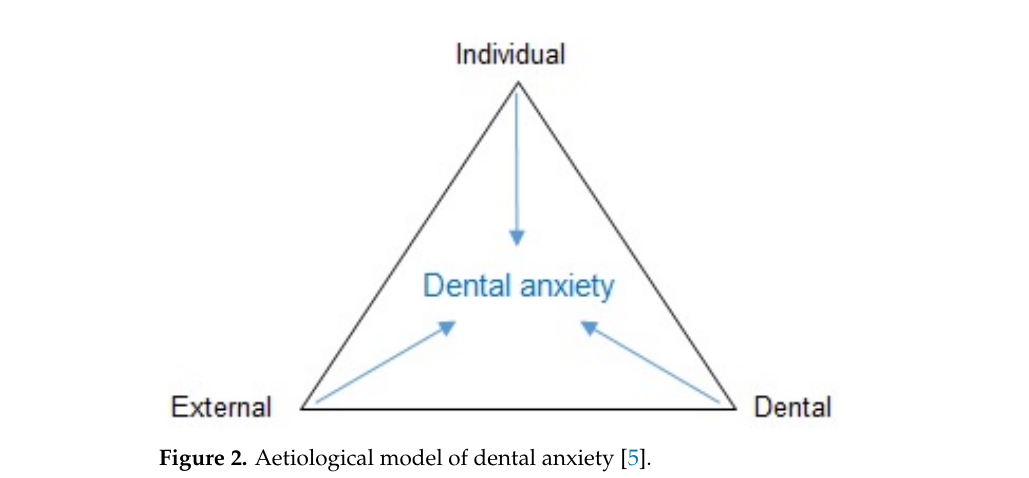
Figure 1. Intuitive analysis of the development of dental anxiety [1].